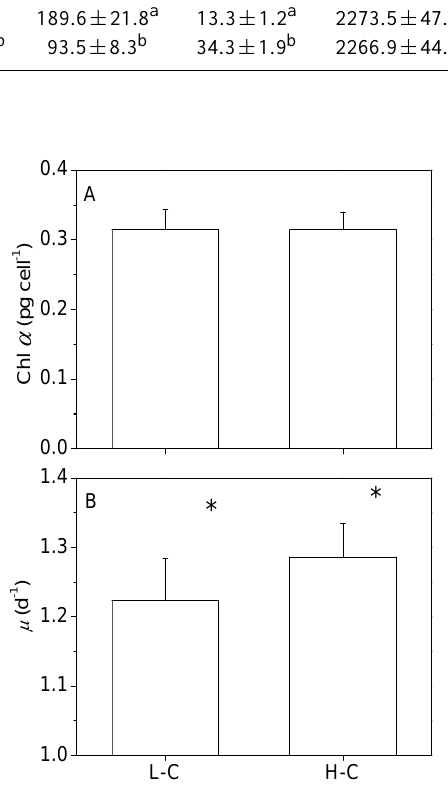
Fig. 1. (A) Cellular chlorophyll- a content and (B) specific growth rate (µ), of P. tricornutum after 20 generations acclimation to the low (L-C; pH 8.15) and high CO 2 conditions (H-C; pH 7.80). Data are the means ± SD of 10 and 27 measurements for the Chl- a and µ, respectively. An asterisk represents significant difference ( p <